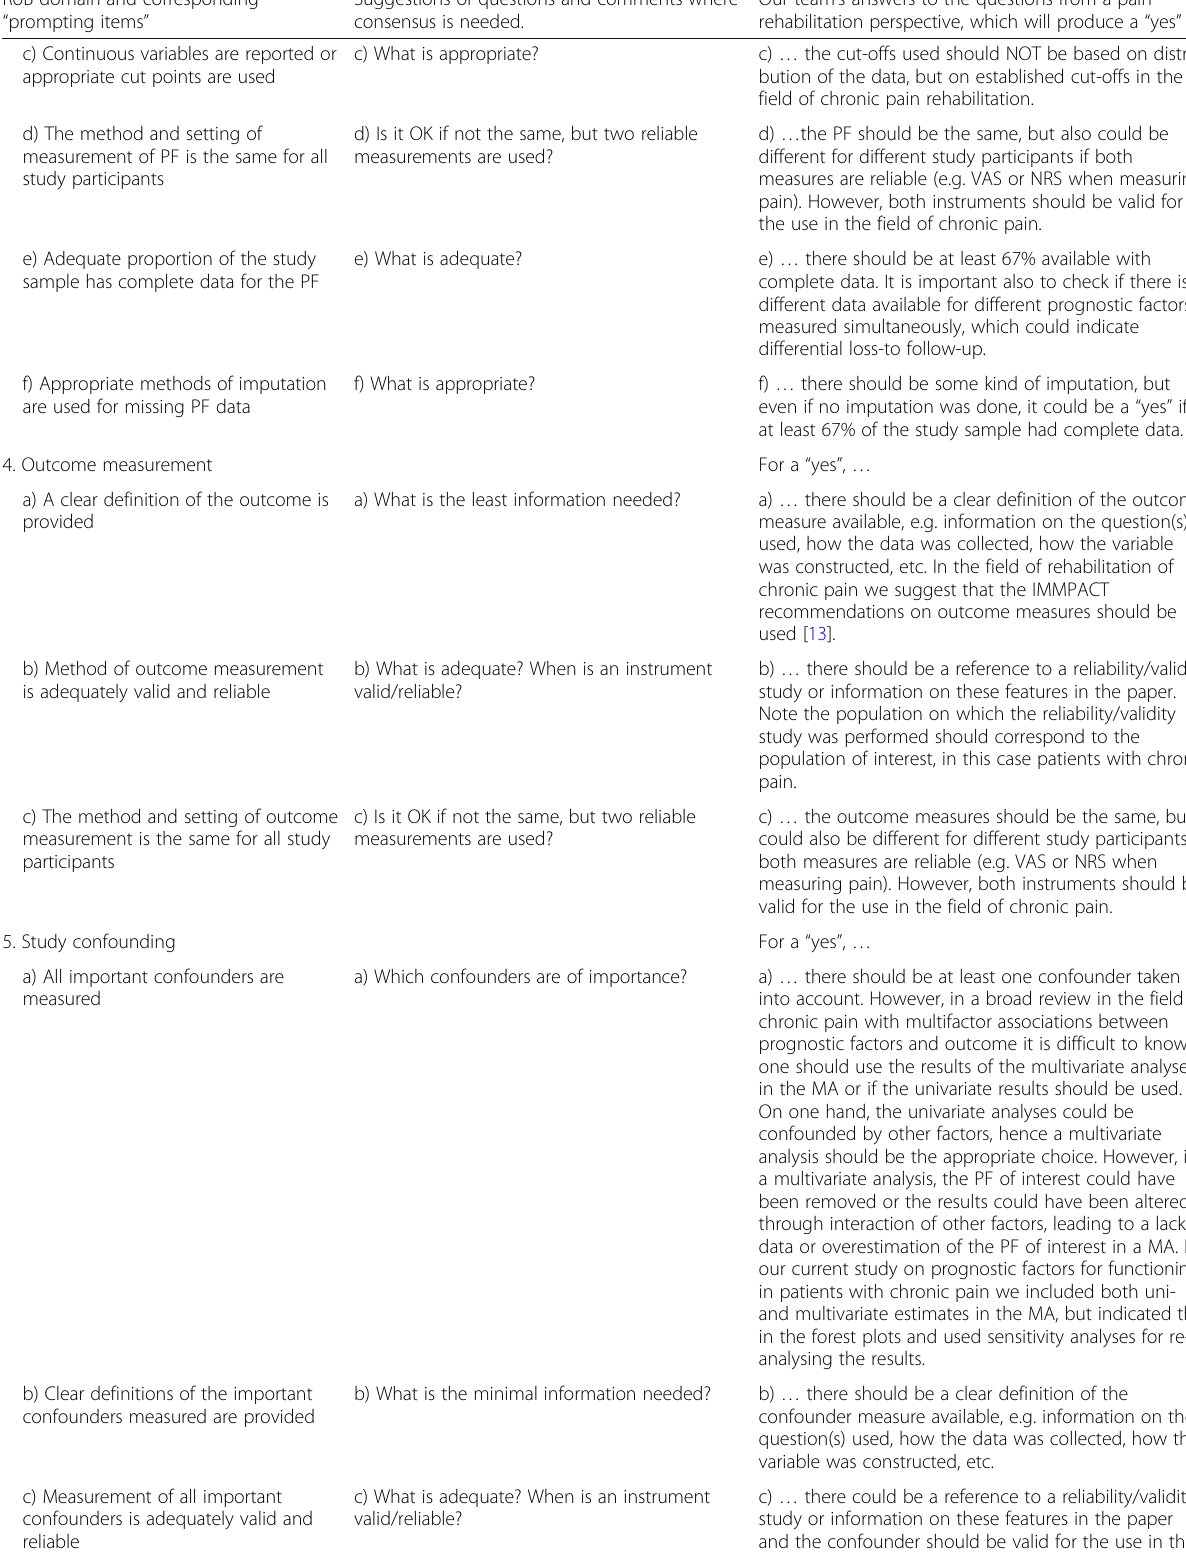
Table 3 Suggestions for questions and comments on QUIPS risk of bias domains and our team ’ s proposed answers (Continued) RoB domain and corresponding “ prompting items